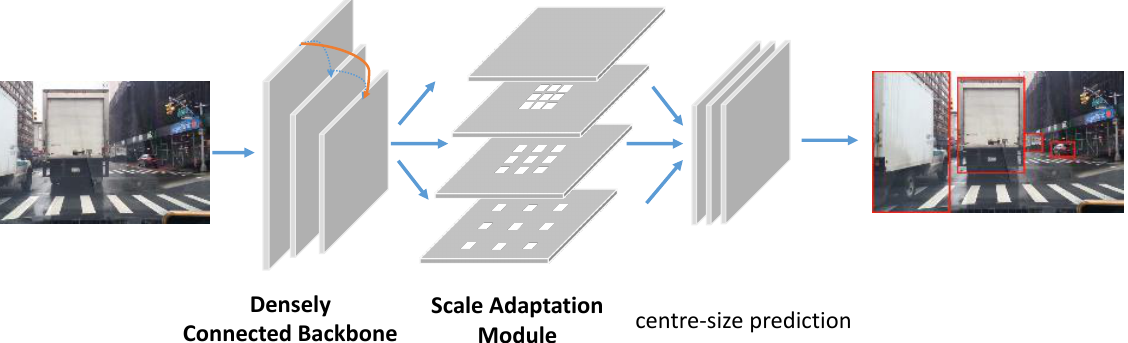
Figure 2. The overall architecture of our SA-CenterNet, which primarily consists of a densely connected backbone, a scale adaptation module and a center-size prediction module. The first two modules are proposed in this paper and introduced in the text below. The center-size prediction module is the same as that in the original